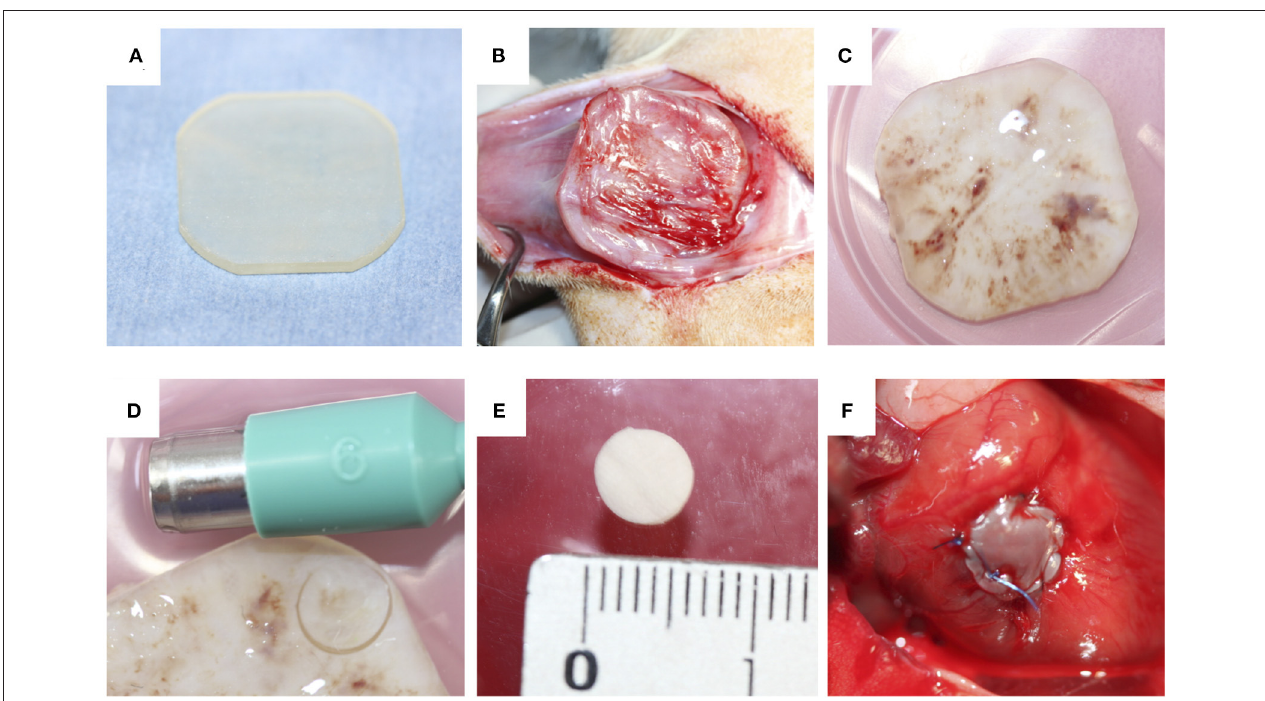
FIGURE 1 | (A) Acrylic plates (25mm × 25mm × 2mm) were used as a mold. (B,C) The molds were completely encapsulated with connective tissues. (D) Pieces of the biosheets were obtained by biopsy punch (E) . The obtained biosheet (F) .